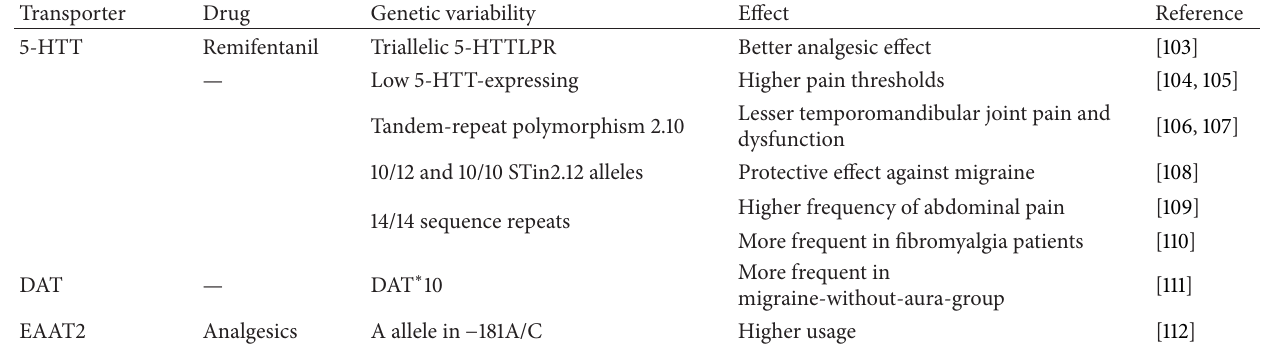
Table 7: Impact of genetic variability in genes for transporters of